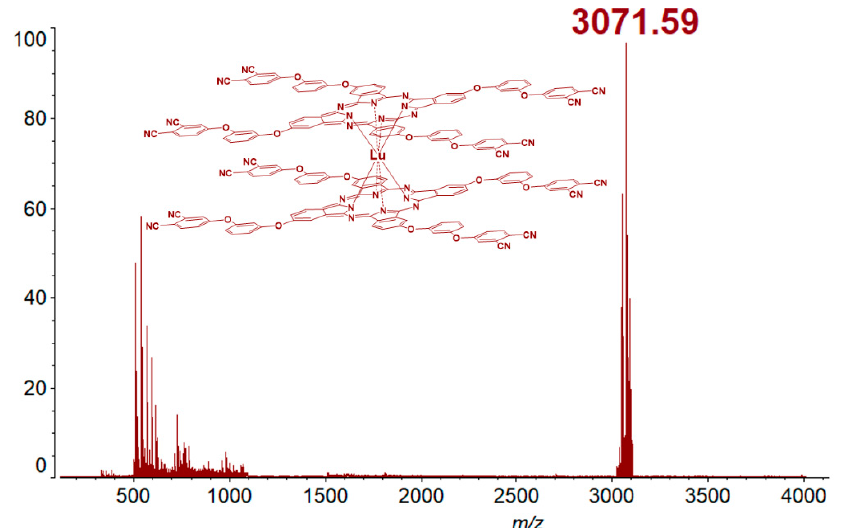
Figure 2. HR MALDI-TOF mass-spectrum of bistetrakis-4-[3-(3,4-dicyanophenoxy)phenoxy]phthalocyaninato lutetium ( 4 ) (CHCA as matrix).